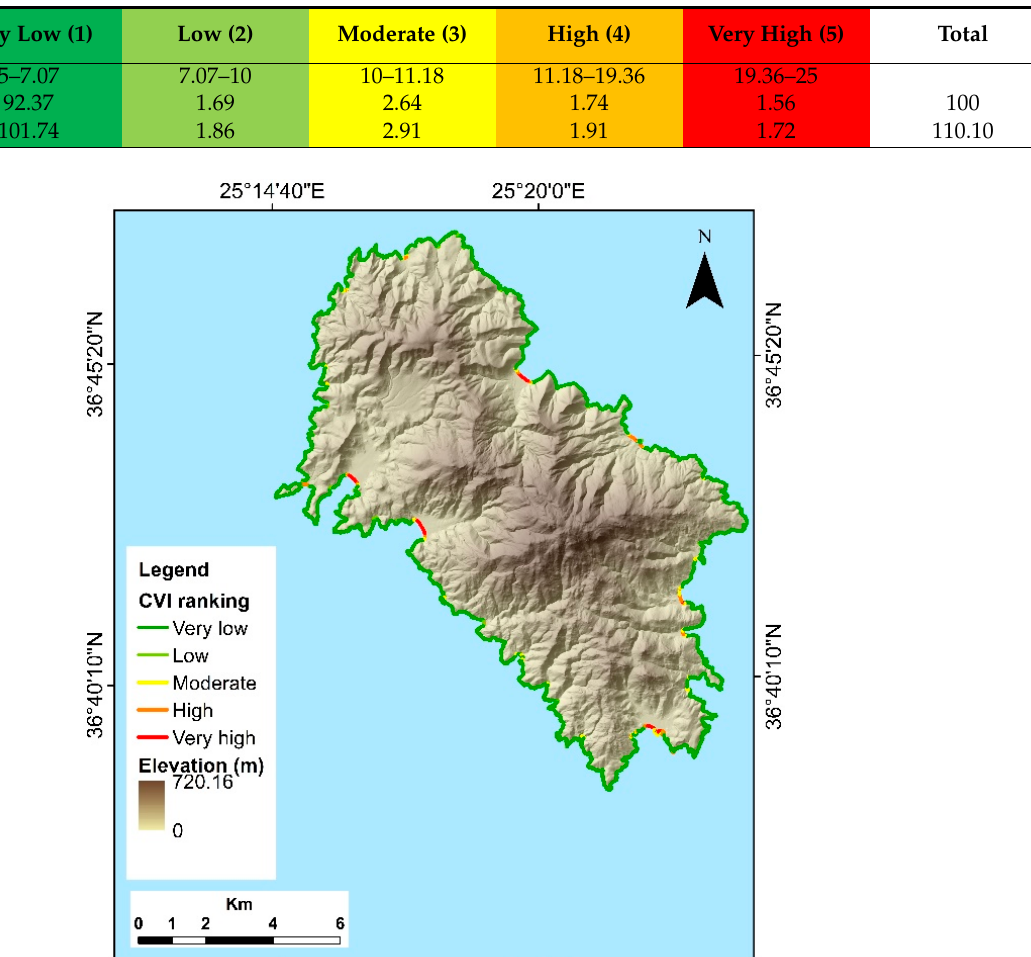
Table 4. Ranking of the CVI values. The table indicates the length, in km and percentage, of coastline in each category of vulnerability.